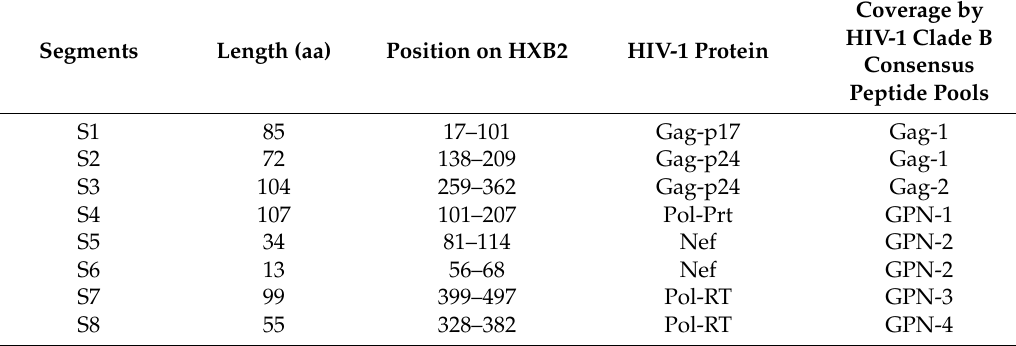
Table 1. Characteristics of the eight HIV-1 segments included in the T cell multiepitopic peptide (TMEP-B) sequence. GPN: Gag–Pol–Nef; Prt: protease; RT: reverse